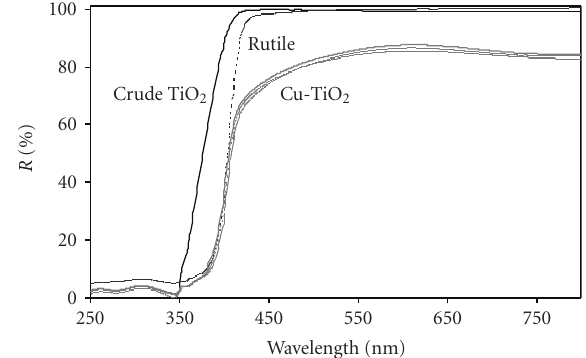
Figure 2: UV/Vis-DR spectra of crude TiO 2 , rutile and Cu-rutile